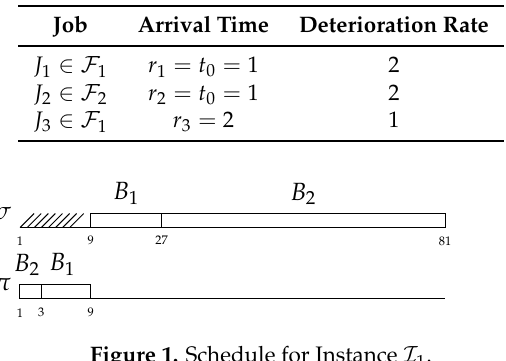
Figure 1. Schedule for Instance I 1